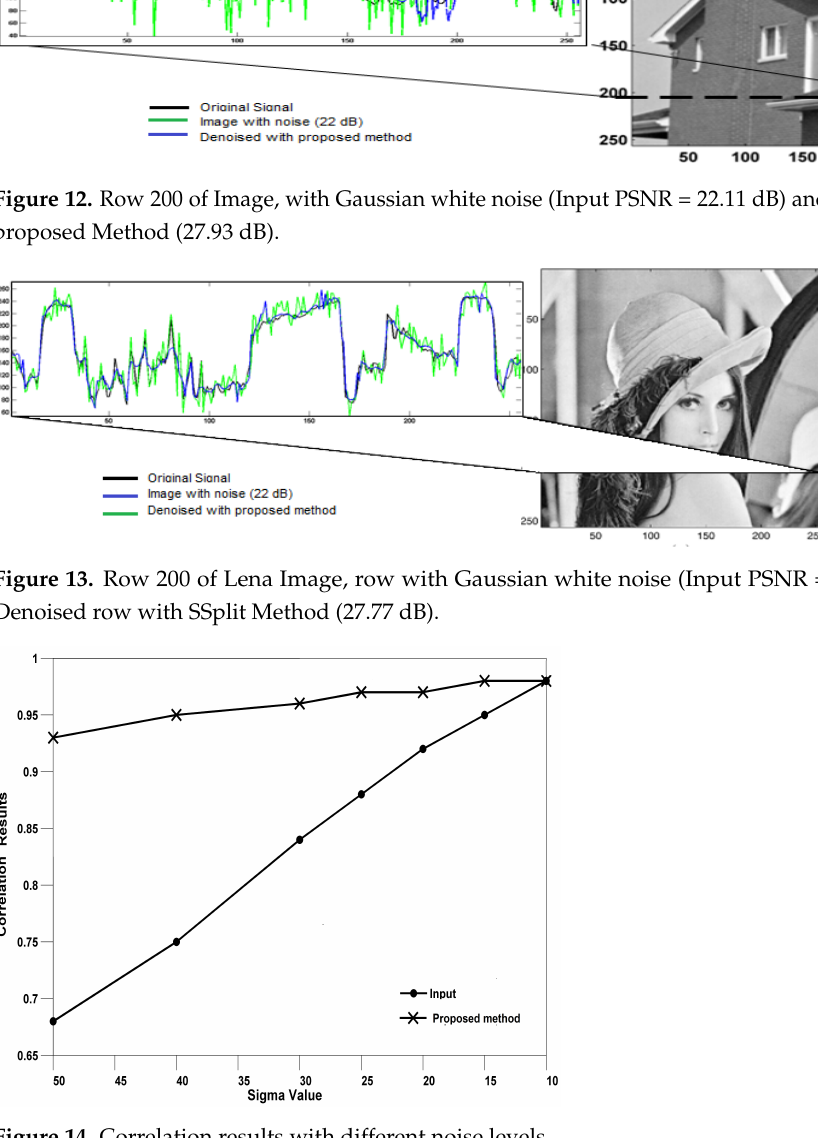
Figure 14. Correlation results with different noise